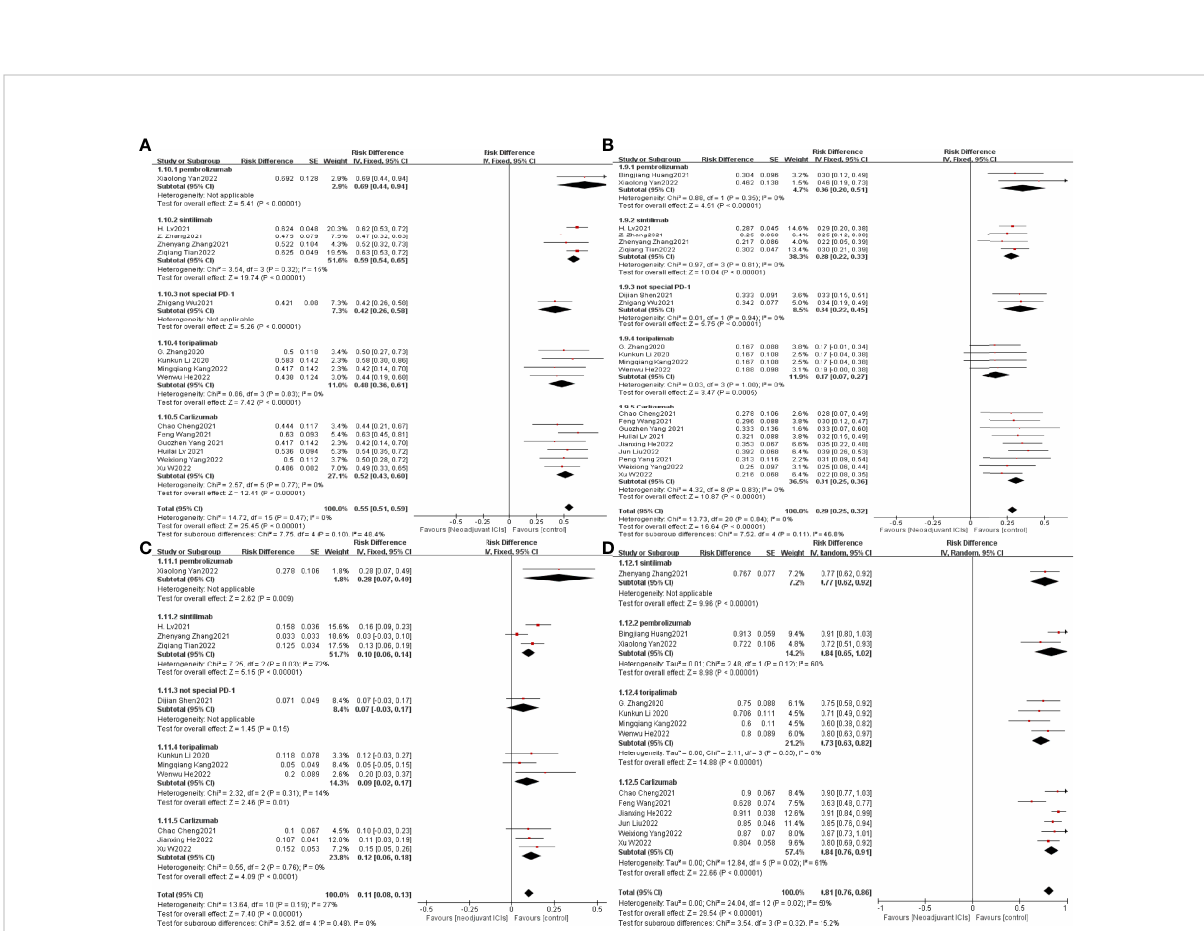
FIGURE 12 Subgroup analysis was based on ICIs categories grouped separately with MPR (A) , PCR (B) , TRAEs (C) , and surgical resection rates (D)